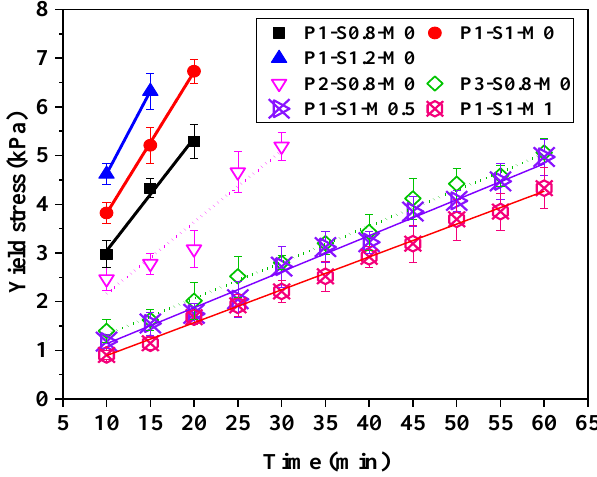
Figure 5. Evolution of static yield stress of samples with time. Table 3. Static rheological parameters of samples obtained by the Roussel model.